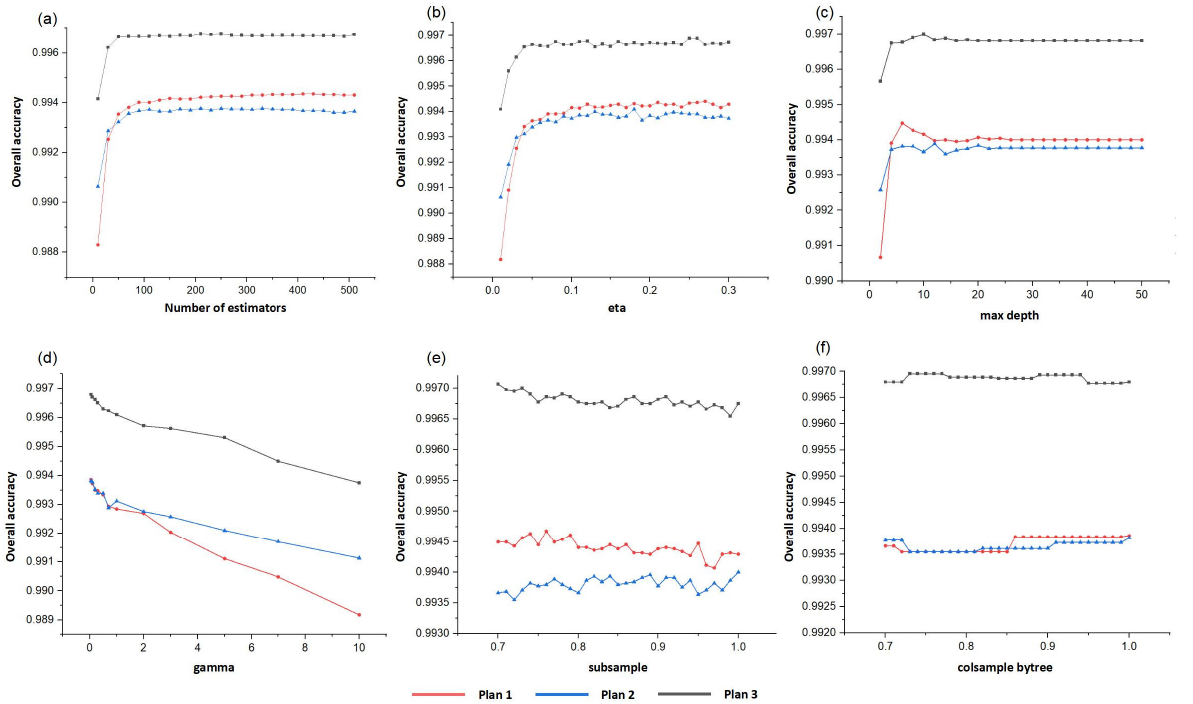
Figure 5. XGBoost model hyperparameter conditioning curves. ( a ) Number of estimators; ( b ) eta; ( c ) max depth; ( d ) gamma; ( e ) subsampl; and ( f ) colsample bytree.